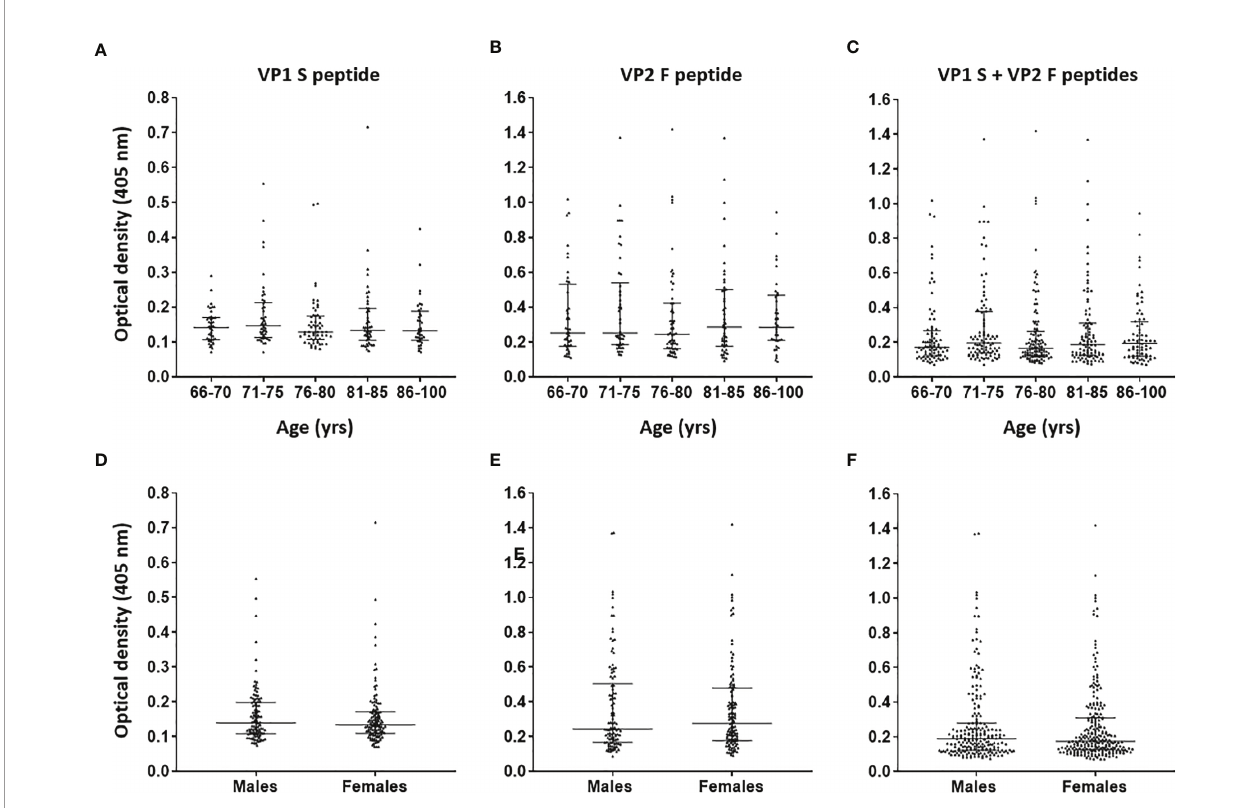
FIGURE 2 | Serological pro fi les of serum antibody reactivity to Merkel cell polyomavirus (MCPyV) VP1 S (A, D) , VP2 F (B, E) peptides and for combined S and F peptides (C, F) in age- and gender-strati fi ed elderly subjects (ES). Immunologic data are from age- and gender-strati fi ed ES, and results are reported as optical density (OD) value readings at l 405nm for serum samples assayed in indirect ELISA. In the scatter dot plot, each dot represents the dispersion of ODs for each sample. The median is indicated by the line inside the scatter plot with the interquartile range (IQR) in age-strati fi ed ES, i.e., 66 – 70 (n = 40), 71 – 75 (n = 46), 76 – 80 (n = 57), 81 – 85 (n = 47), and 86 – 100 (n = 36) years and in gender-strati fi ed ES, i.e., males (n = 106) and females (n = 120). No statistically signi fi cant differences in MCPyV seroreactivity were determined among age-/gender-strati fi ed groups (p >